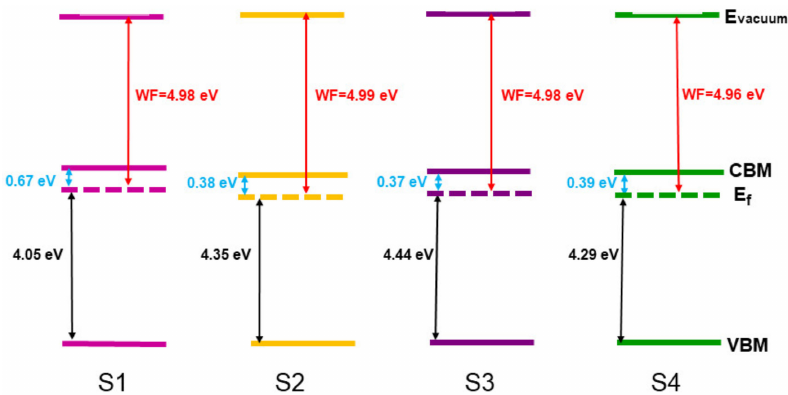
Figure 6. Schematics of energy level structure for Nb doped β -Ga 2 O 3